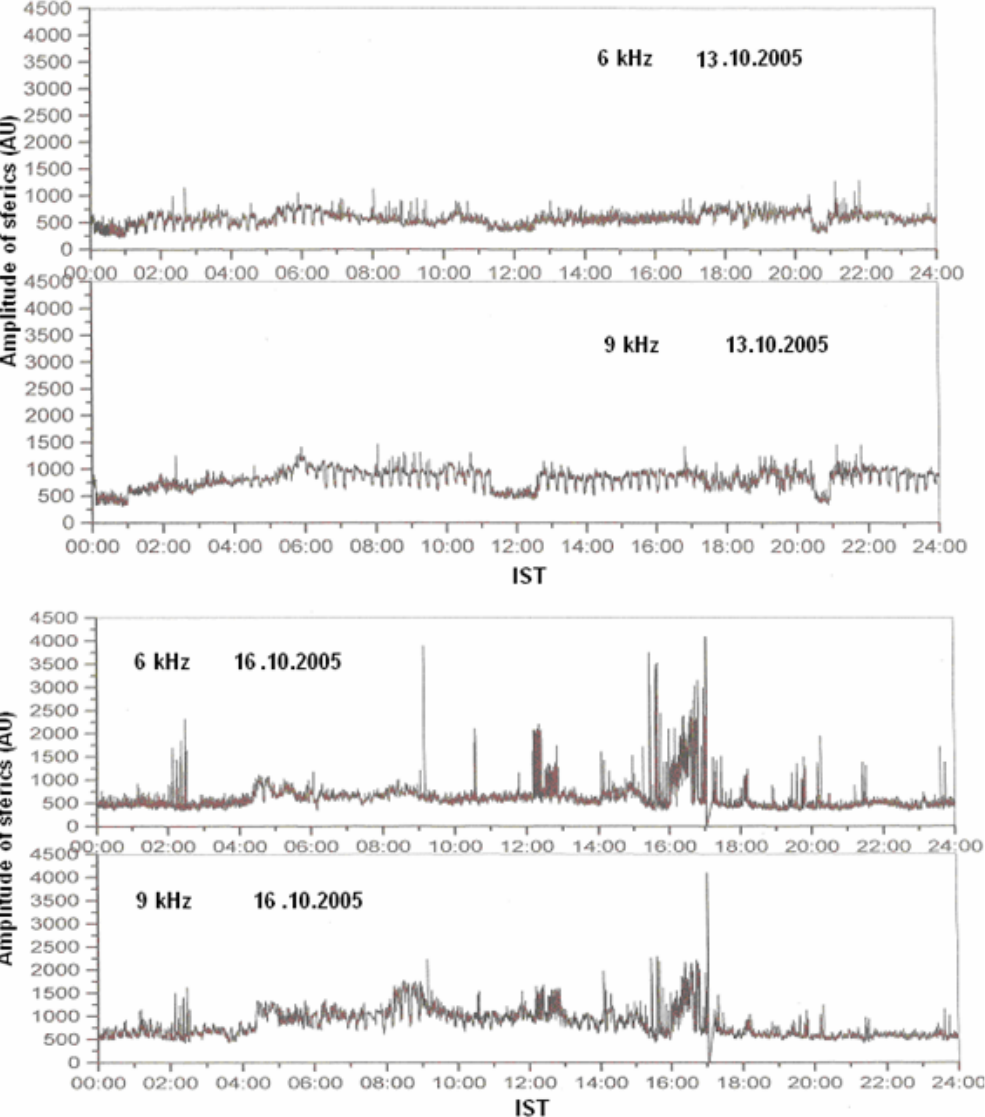
Fig. 12. Diurnal variation of sferics observed over Agartala on 13 October (upper two records) and 16 October 2005 (lower two